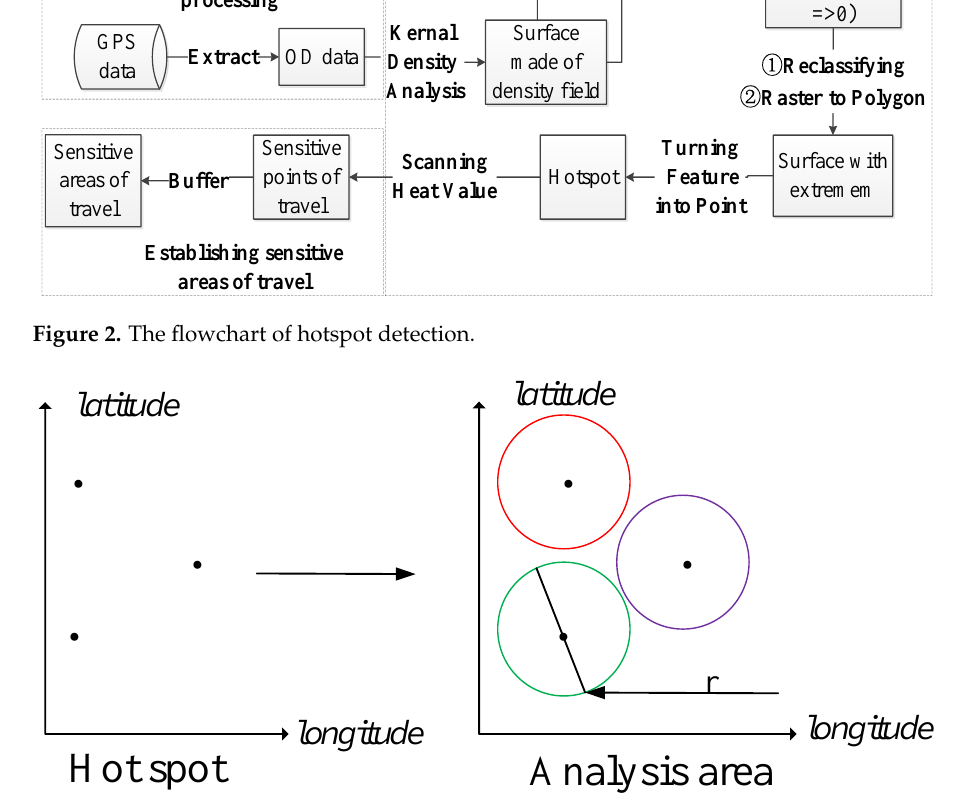
Figure 3. The analysis areas for modeling bottlenecks of bike-sharing travel. Black spots are hotspots (analysis spots); the circle is the 500 m buffer using the hotspot as the center point; r is the radius of 500 m.